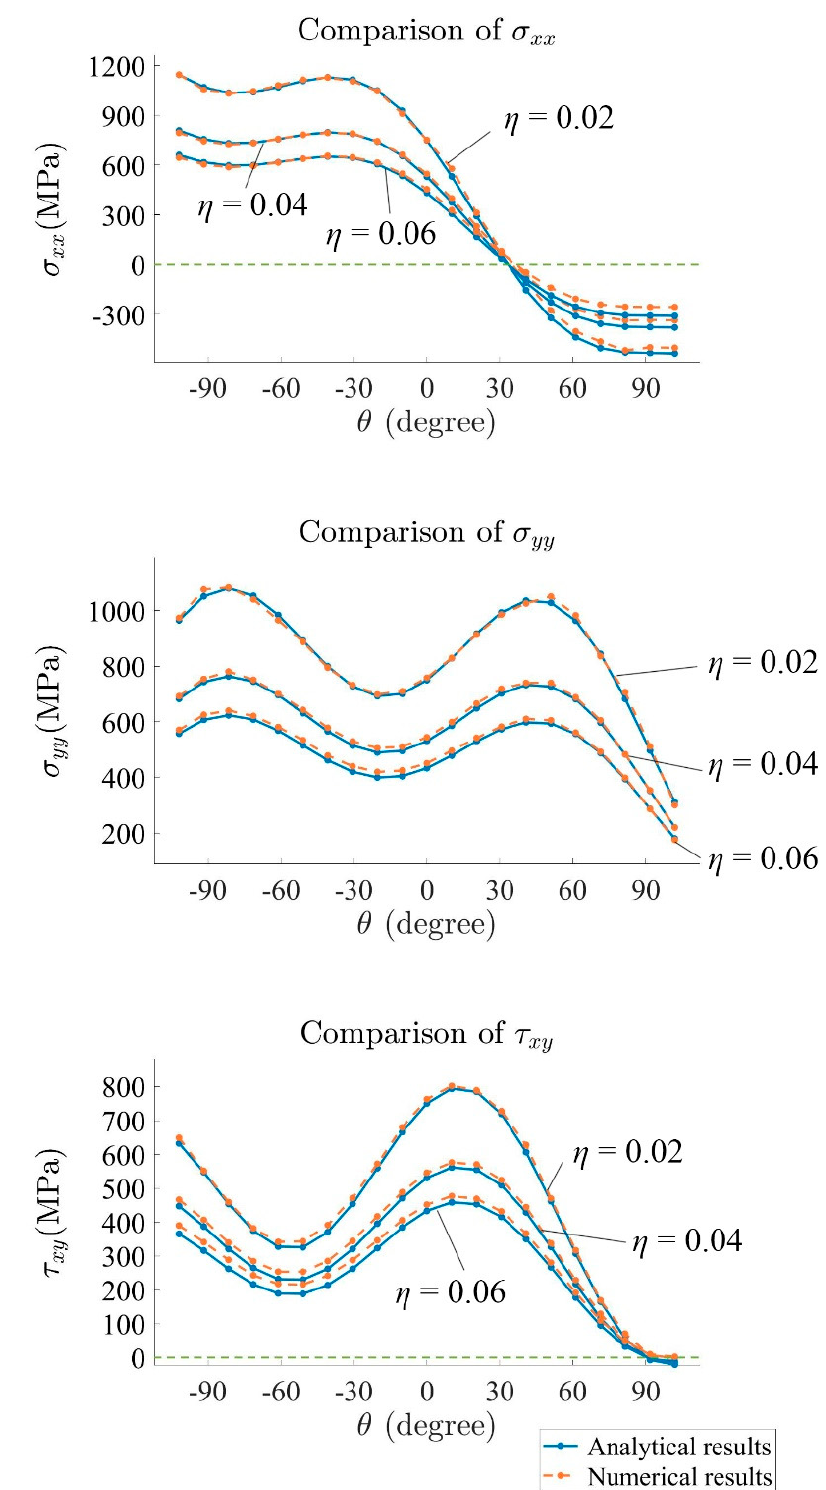
Figure 18. Comparison between stresses from numerical and analytical results.